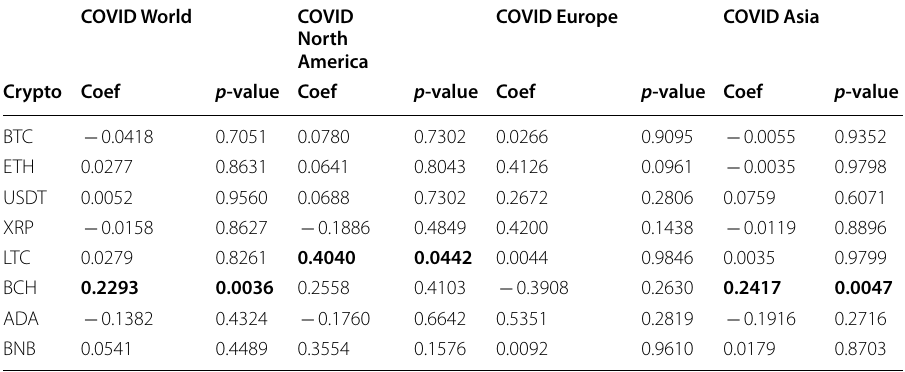
Table 3 CC variations in daily trading volume models are explained by the absolute variation of the effective reproductive rate